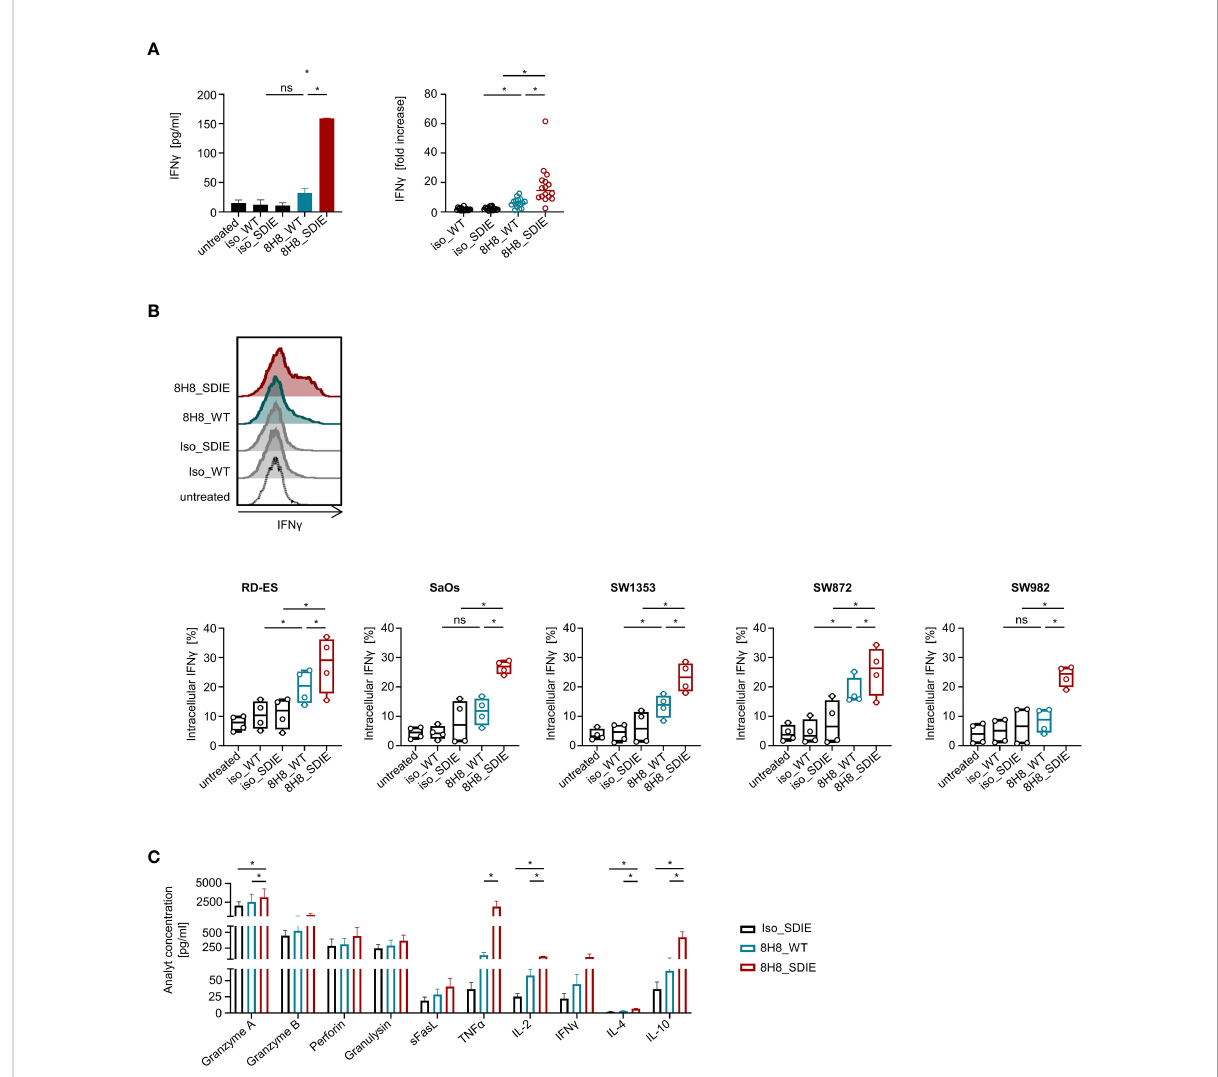
FIGURE 4 Induction of immunoregulatory molecules by B7-H3 antibodies against sarcoma cells. Healthy donor PBMC were cultured with sarcoma cells at an E:T ratio of 2.5:1 in the presence or absence of 8H8_WT, 8H8_SDIE or the corresponding isotype controls (1 m g/mL) (A,B) Supernatants and NK cells within PBMC were analyzed for IFN g . (A) Release of IFN g after 24 h was analyzed in supernatants of cocultures by Legendplex assays. In the left panel, exemplary results with SW1353 are shown, in the right panel results obtained with sarcoma cell lines RD-ES, SaOs, SW1353 and SW872 and with PBMC of four independent donors are shown. (B) Intracellular expression of IFN g in NK cells within PBMC identi fi ed by counterstaining with CD3 - CD56 + was analyzed after 4 h by fl ow cytometry. In the upper panel, exemplary results obtained with SaOs and in the lower panel data obtained with sarcoma cells (RD-ES, SaOs, SW1353, SW872 and SW982) and with PBMC of four independent donors are shown. (C) Supernatants were analyzed for effector molecules Granzyme A, Granzyme B, Perforin, Granulysin and sFasL and for release of immunoregulatory molecules TNF a , IL-2, IFN g , IL-4, IL-10 after 4 h by Legendplex assays. Shown are pooled results with sarcoma cell lines SW1353 and SW872 and with PBMC of two independent donors. ns, not signi fi cant; *statistically signi fi cant differences (p-value <